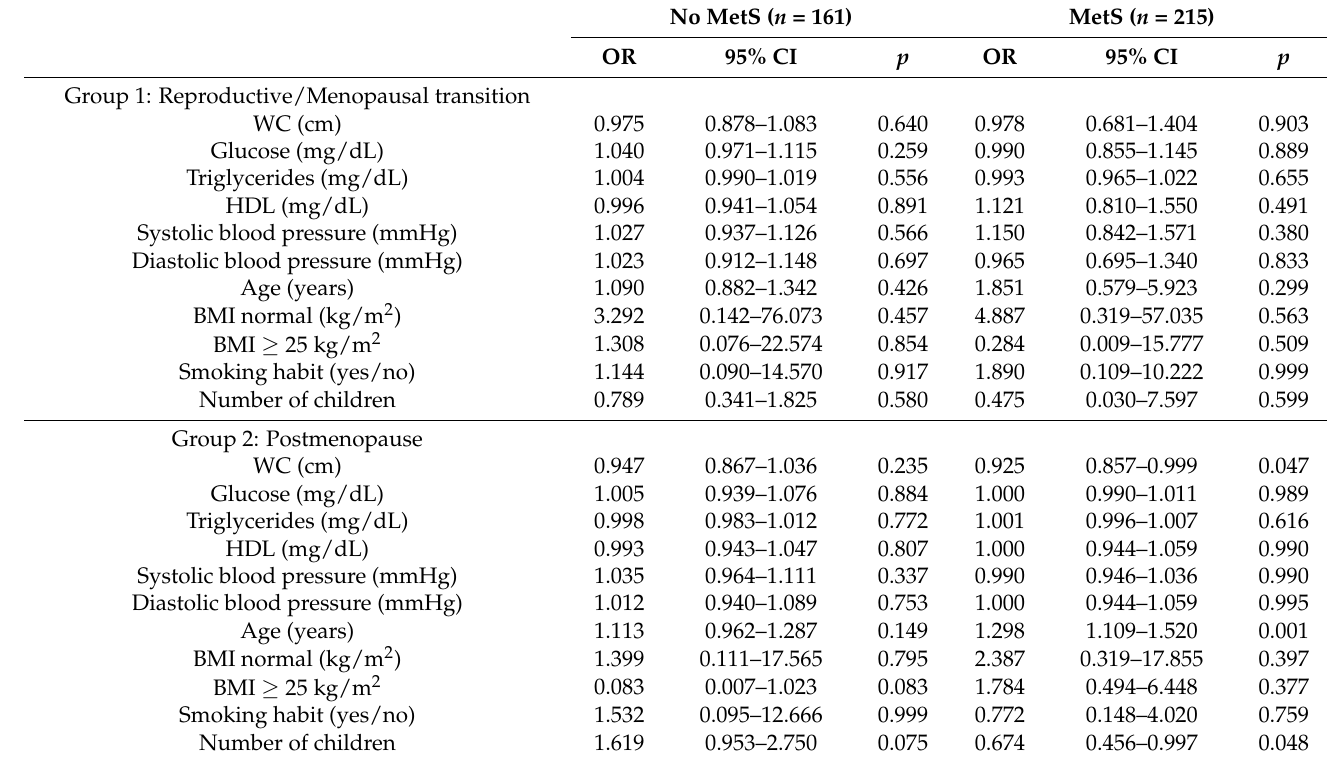
Table 2. Multivariate logistic regression analysis of low bone mineral density (osteopenia/osteoporosis) in the dual femur in 40–60-year-old women.